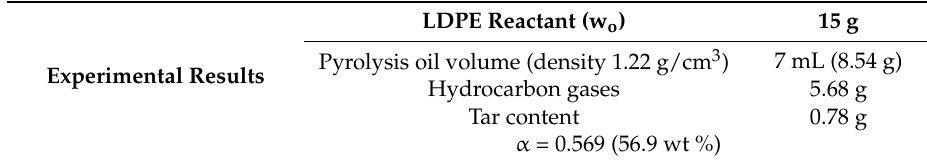
Table 4. Quantitative analysis and mass conversion of the thermoplastic